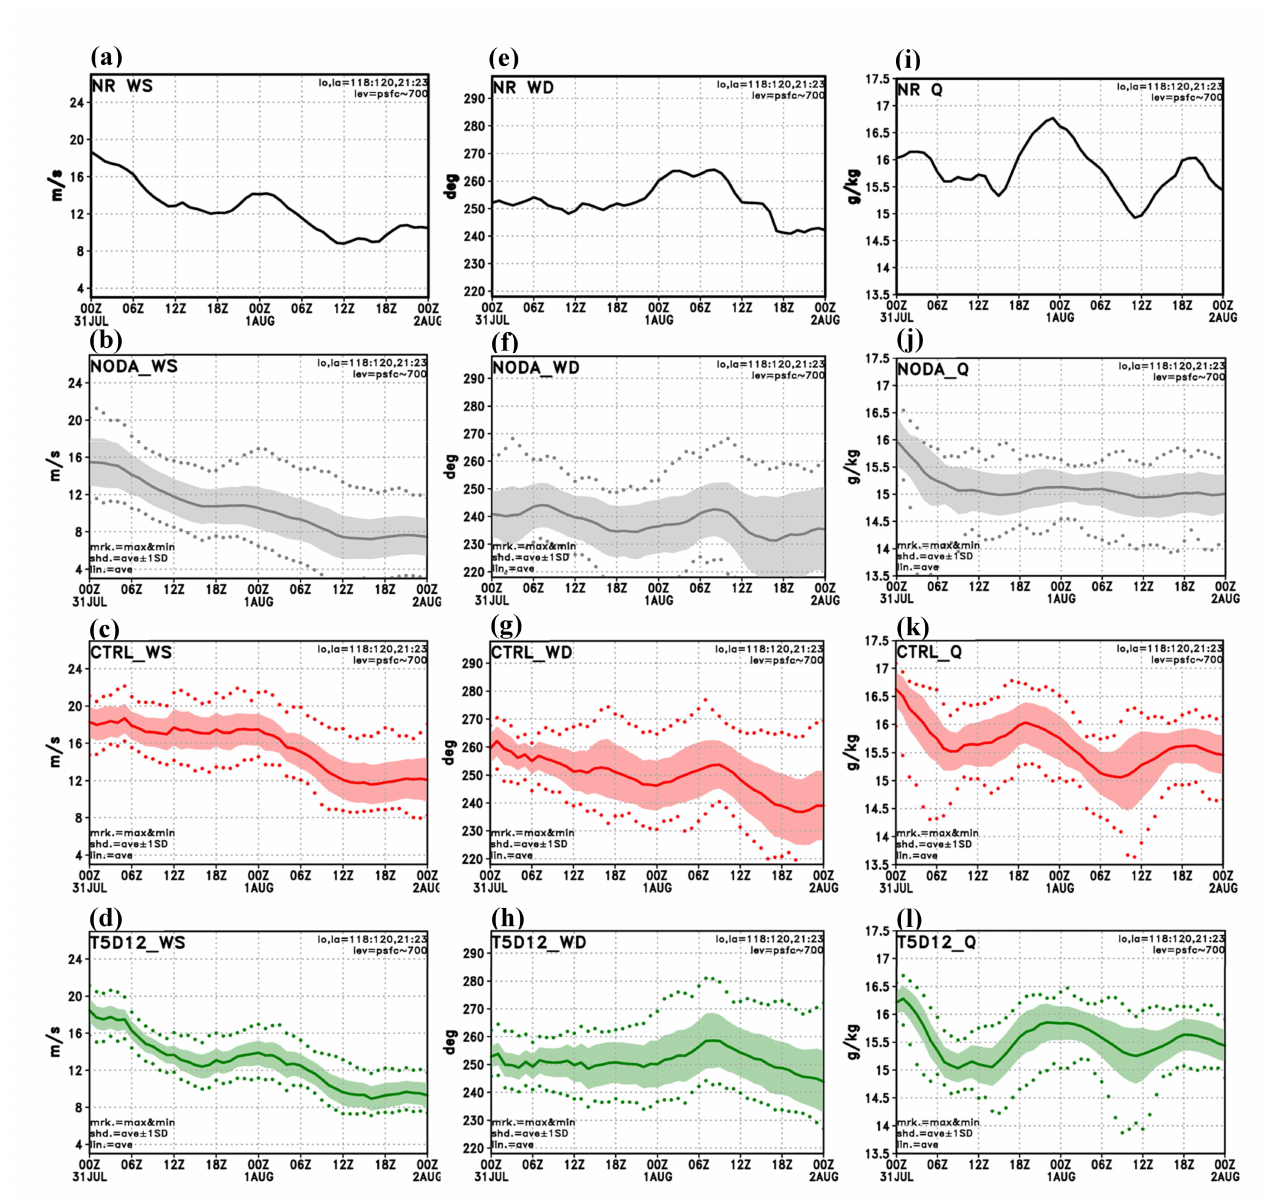
Figure 8. Same as Figure 5 but for the box-averaged low-level ( a – d ) wind speed (m s − 1 ), ( e – h ) wind direction (degree), and ( i – l ) mixing ratio (g kg − 1 ) over the ocean southwest of Taiwan (red box in Figure 3b). These variables were also vertically averaged from the surface to 700